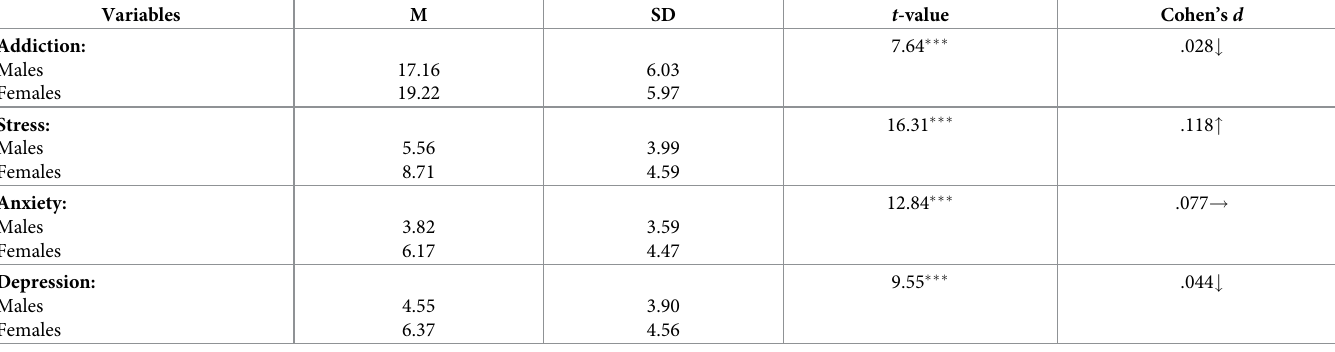
Table 5. T -tests comparing males (n = 947) and females (n = 1,046) in the study variables (df = 1991). Variables